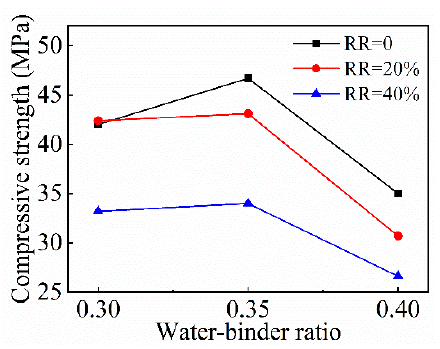
Figure 7. Variation of FRAC compressive strength with w / b